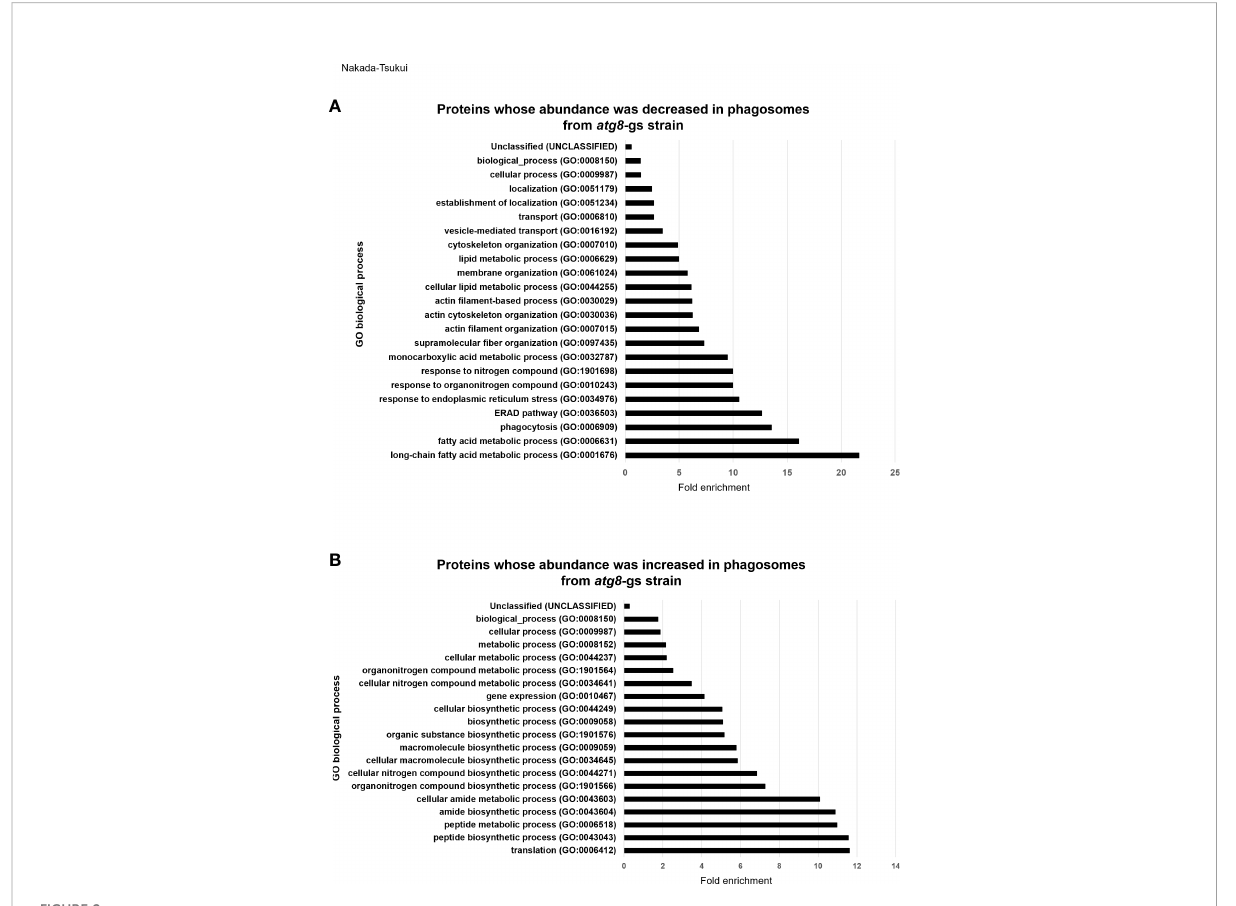
FIGURE 2 GO enrichment analysis of less- and more- abundant phagosomal proteins in atg8 -gs by PANTHER. (A) Result of less abundant proteins in atg8 -gs. All the signi fi cant result (false discovery rate, FDR, <0.05) was shown. (B) Result of more abundant proteins in atg8 -gs. Only highly signi fi cant results (FDR < 1×10 10 ) were shown. All the results with FDR < 0.05 was shown in Supplementary Table